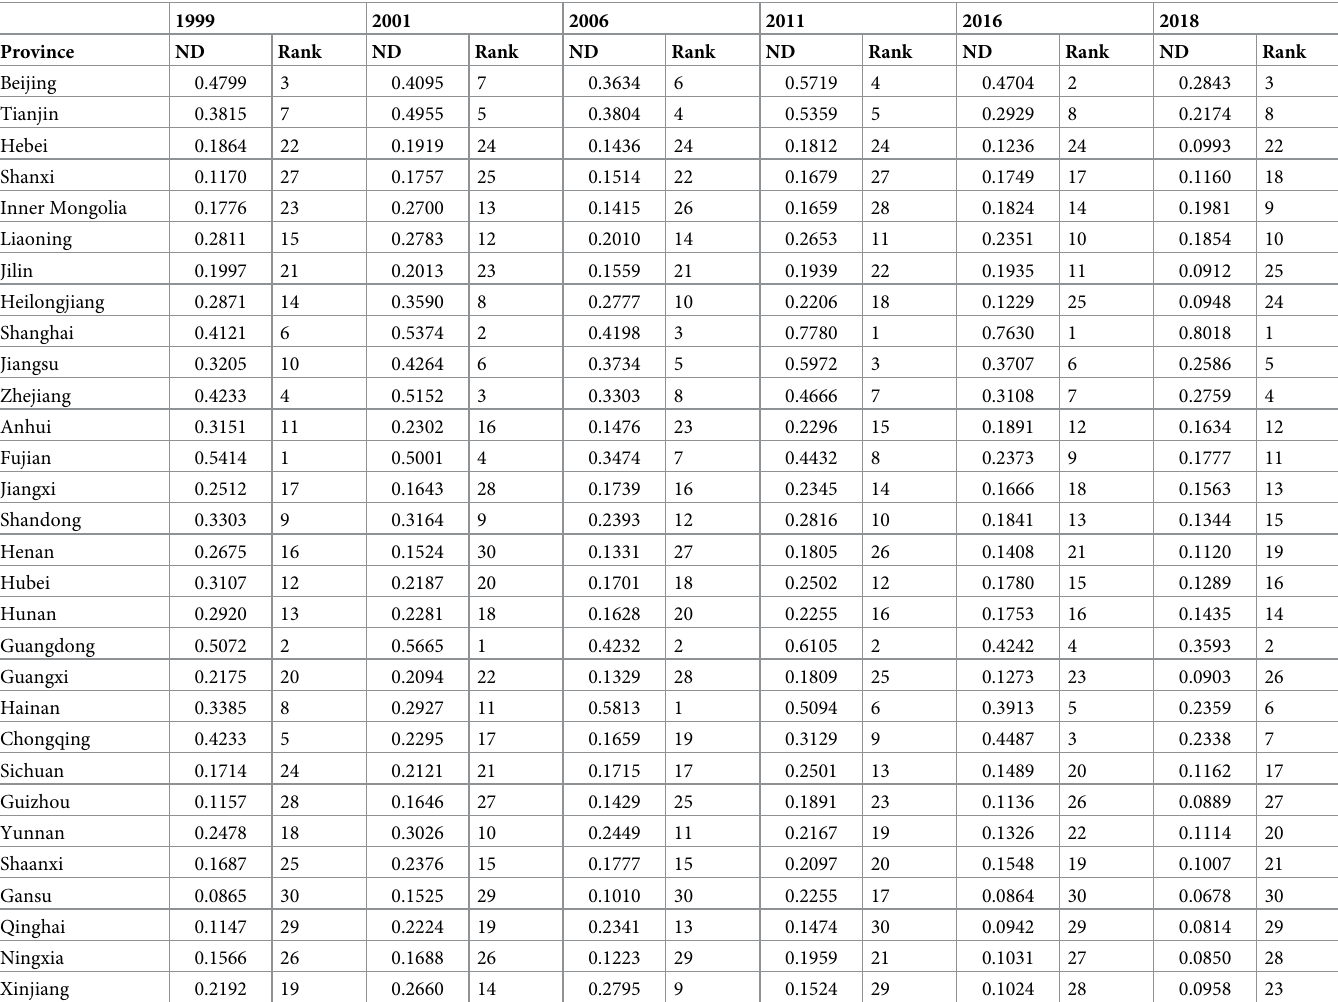
Table 3. Relative nearness degrees and rankings of 30 provinces in 1999, 2001, 2006, 2011, 2014 and